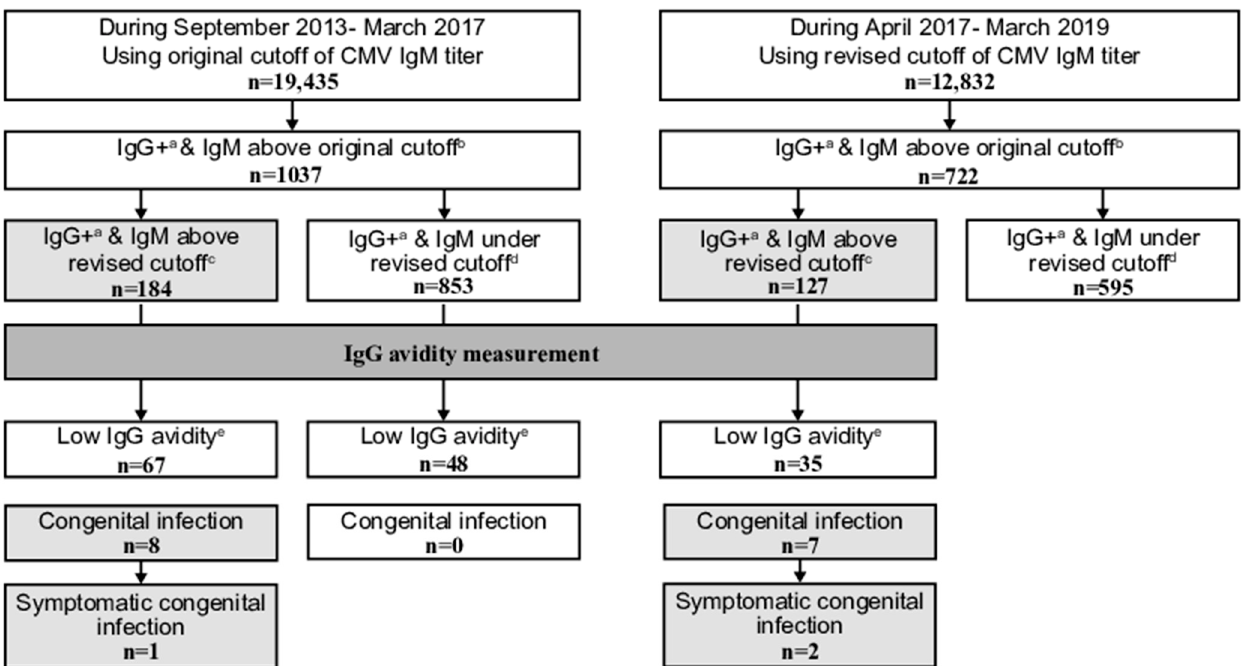
Figure 1. Comparison of positive cytomegalovirus (CMV) immunoglobulin (Ig) G and IgM above the original and revised cutoff results obtained as part of the maternal CMV antibody screening program in pregnant women from September 2013 to March 2017 (using the original cutoff of IgM titer) with those obtained from April 2017 to March 2019 (using the revised cutoff). a including equivocal IgG. b ≥ 1.21 IgM antibody titer. c ≥ 4.00 IgM antibody titer. d <4.00 IgM antibody titer. e ≤ 35.0% IgG antibody avidity index.